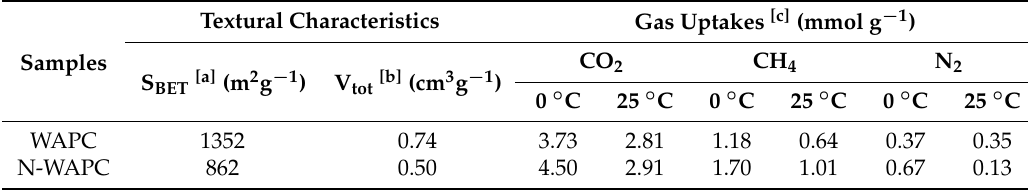
Figure 6. Gas uptake isotherms of CO 2 , CH 4 , and N 2 for ( a ) N-WAPC at 0 ◦ C, ( b ) N-WAPC at 25 ◦ C, ( c ) WAPC at 0 ◦ C ( d ) WAPC at 25 ◦ C. Table 2. Textural characteristics and gas uptakes for WAPC and N ‐ WAPC.